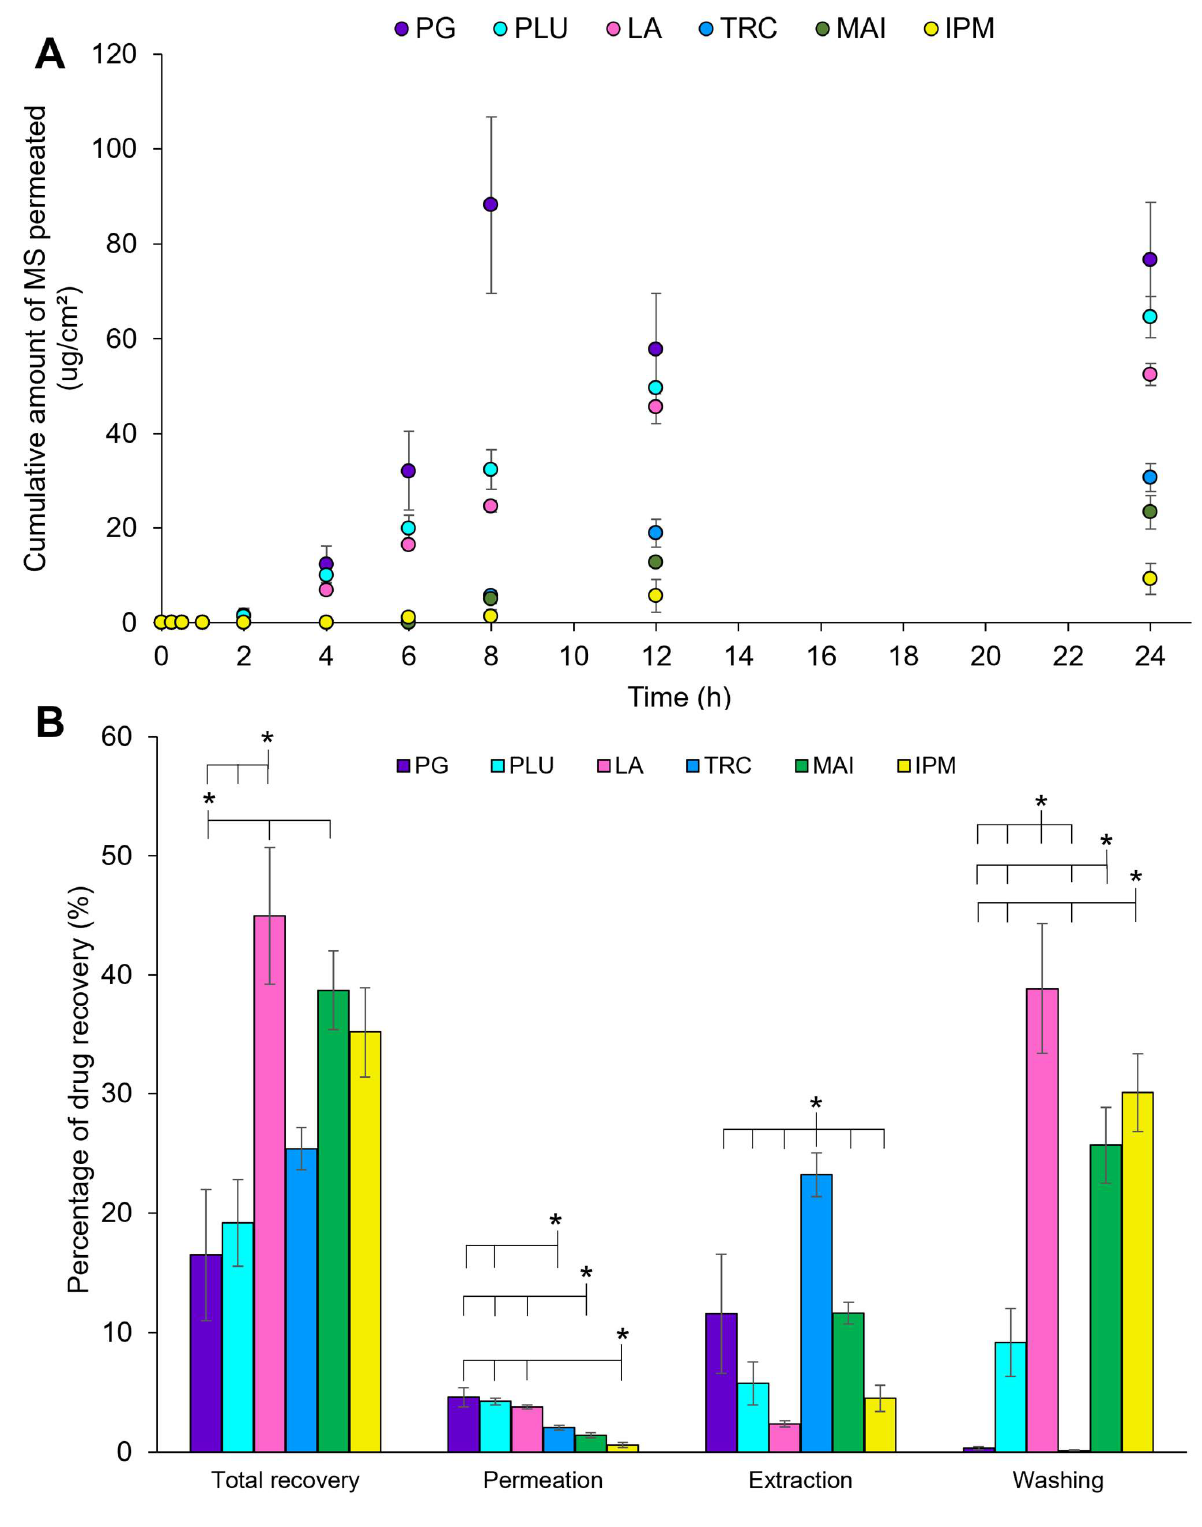
Figure 2. ( A ) In vitro permeation and ( B ) mass balance studies of 10% v / v of MS in neat solvents (PG: propylene glycol; PLU: Plurol ® oleique CC 497; LA: Labrasol ® ; TRC: Transcutol ® P; MAI: Maisine ® CC; IPM: isopropyl myristate) for finite dose (10 μL/cm 2 ) with occlusion over 24 h using porcine ear skin (n = 3, mean ± SD; * p < 0.05, ANOVA).